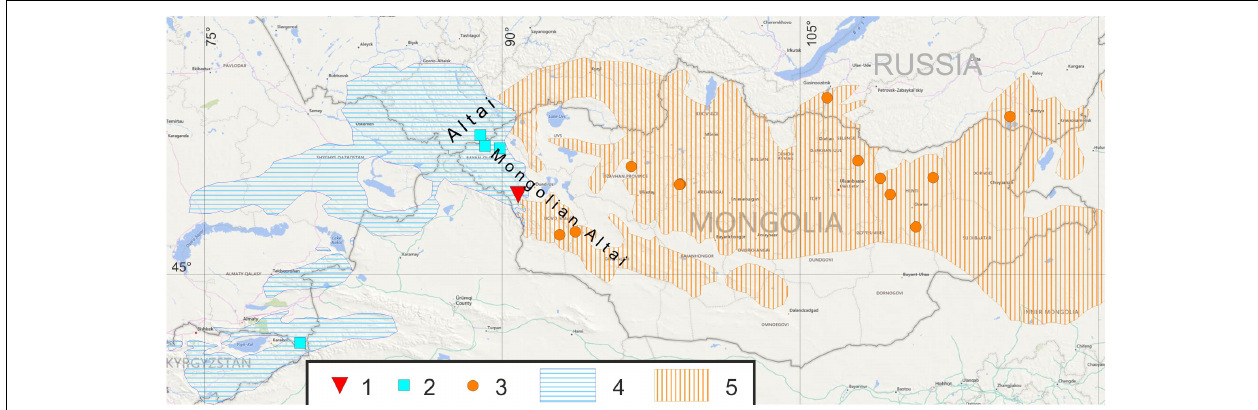
FIGURE 1 | Localities of studied marmot population and reference populations: (1)—population of Ulagchin-Gol valley; (2)— M. baibacina reference populations; (3)— M. sibirica reference populations. Distribution of marmots: (4)— M. baibacina ; (5)— M. sibirica . Compiled from IUCN database, Brandler (2003); Kolesnikov et al. (2009), Kryštufek and Vohralík